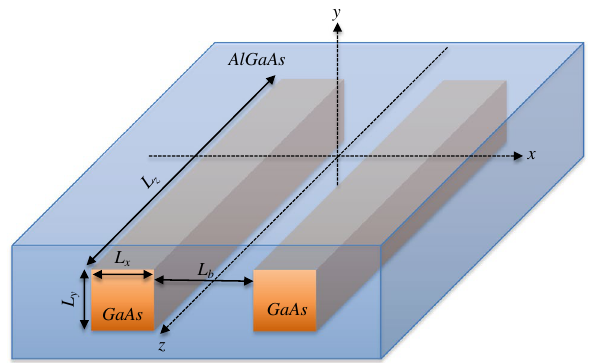
2 parallel quantum wires array as the studied in this work: square Figure 1. Schematic representation of a 1 × GaAs wires, with the axis directed along the z -direction, are embedded into an AlGaAs matrix and separated by a distance L b